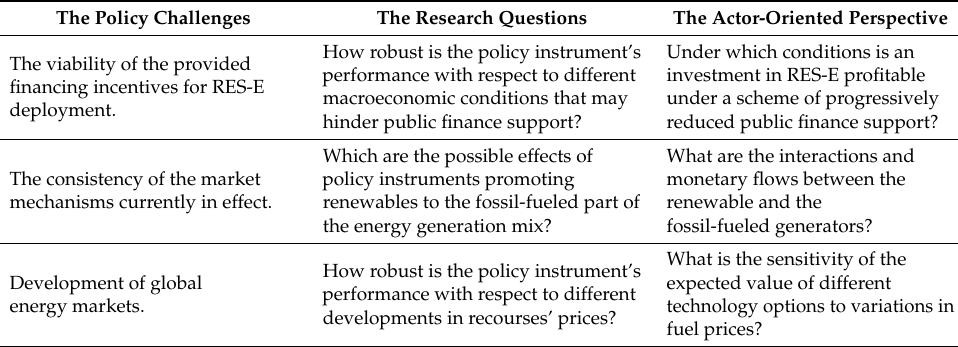
Table 1. Perceiving the policy challenges through an actor-oriented point of view.The first column contains the policy challenges that form the respective policy scenarios and need to be properly addressed. The second one lists the research questions shaping the policy-relevant scenarios. Finally, the third column exhibits the actor-oriented point of view envisaging the scope of perception of the policy challenges to be addressed and of the policy scenarios to be